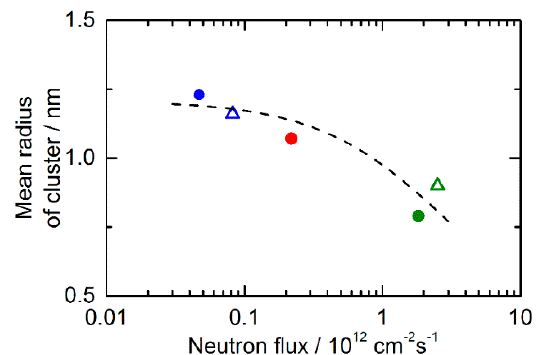
Figure 9. Cluster radius by SANS as a function of flux. The base material is indicated by the full circles, and the weld by the open triangles. The data point for the same RPV base material is indicated by the red dot from [40]. The dashed line corresponds to the model based on deterministic growth [23].